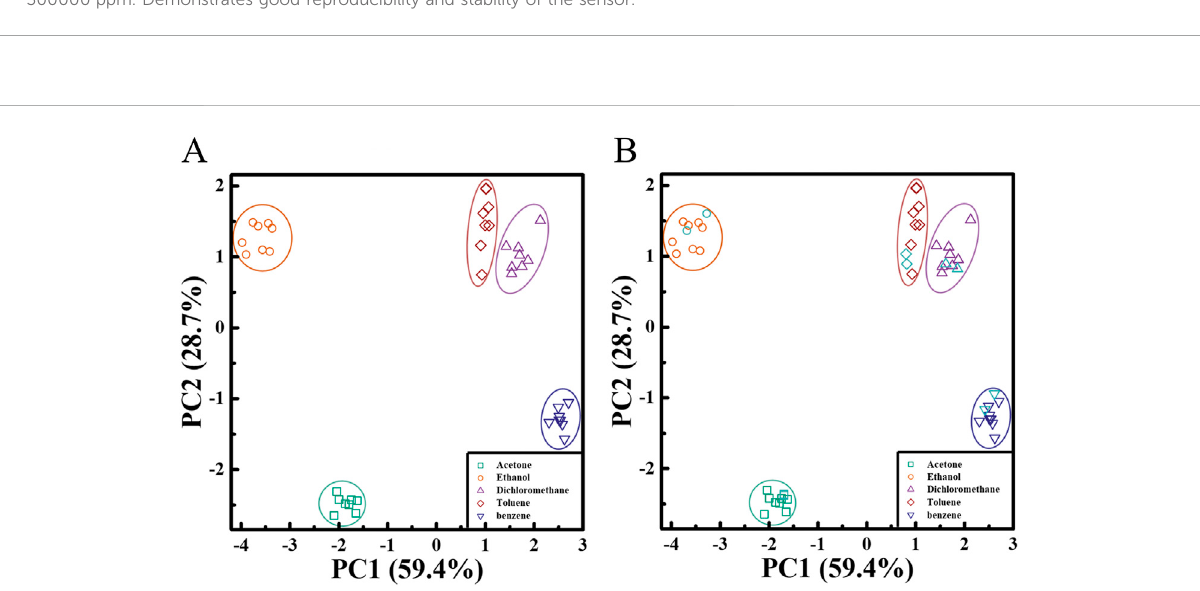
FIGURE 4 Array-based organic vapor sensing and similar organic vapor identi fi cation (A) PCA plots, calculated from fl uorescence intensity variation data obtained for four polymer/TPMN array sensors during exposure to fi ve organic vapors, as shown in the fi rst two main axes of PC1 and PC2. The four commercial polymers used include PS, PMMA, PES, and PVP, and the AIE molecule is TPMN. The PCA algorithm shows that PC1 and PC2 capture 88.1% of the variance of the data, indicating that the different types of organic vapors are well separated. (B) Validation of the proposed classi fi cation method. Two additional sets of data from these fi ve organic vapors (sky blue) were measured and evaluated, and whether the sensors could correctly identify organic vapors by their vapor locations in the PCA plot. The results show that our proposed method can classify and identify the different organic vapors